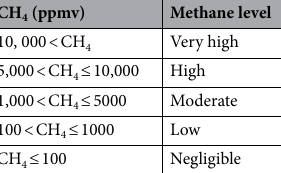
Table 1. Methane concentration